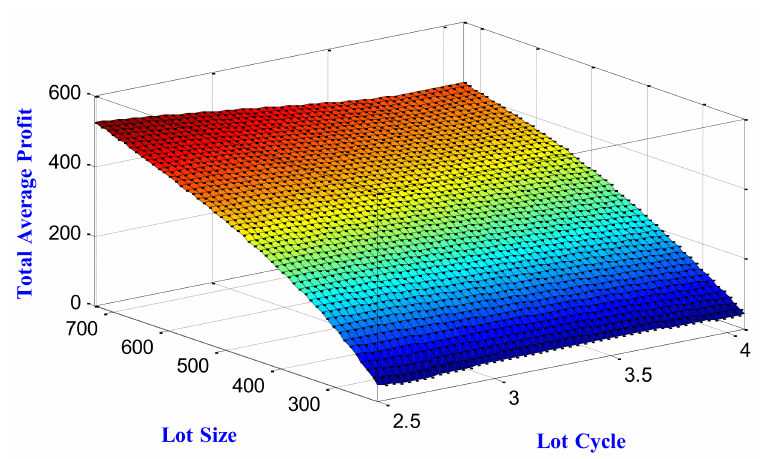
Figure 10. Three-dimensional dependency among total average profit, lot cycle and lot size for the case of no